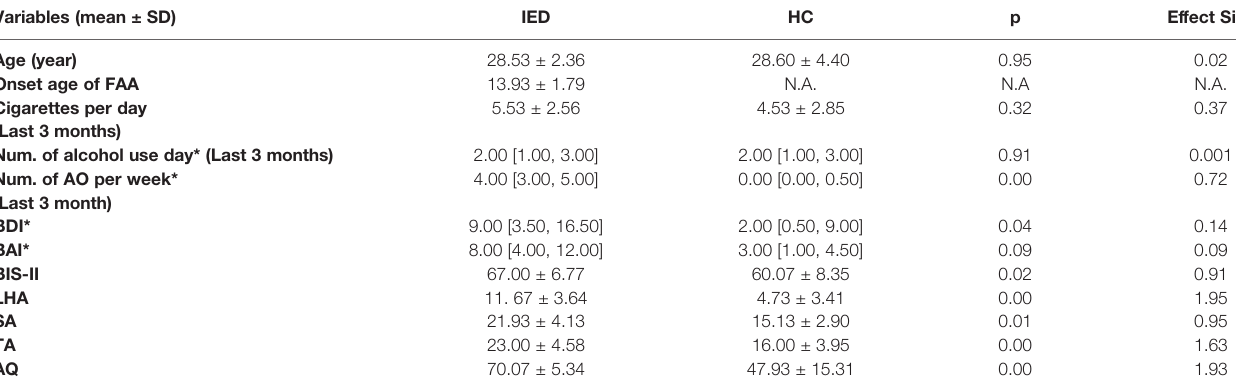
TABLE 1 | Demographic and clinical characteristics of the IED and control groups.